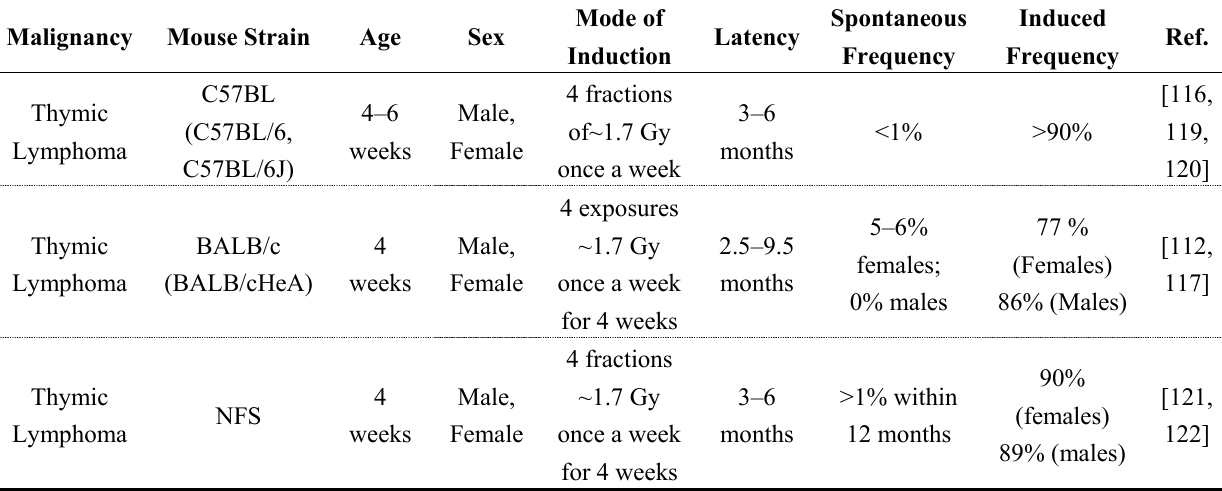
Table 2. Induction of thymic lymphoma in mice with low-LET ionizing